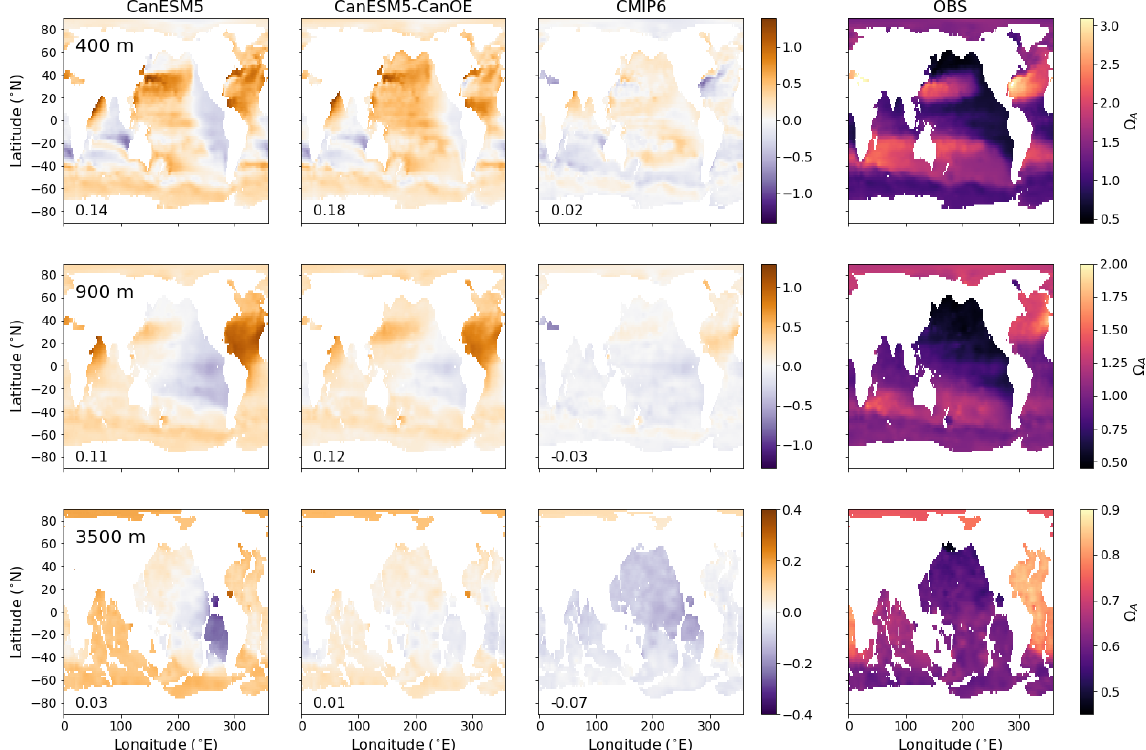
Figure 6. Global distribution of aragonite saturation ( (cid:127) A ) at 400, 900, and 3500m for CanESM5-CanOE, CanESM5, the mean for other CMIP6 models, and observations (GLODAPv2 and WOA2018). Note different colour scales for different depths. Numbers on the lower left are the mean model bias. Differences from the observation-based fields are shown in Fig. S2 in the